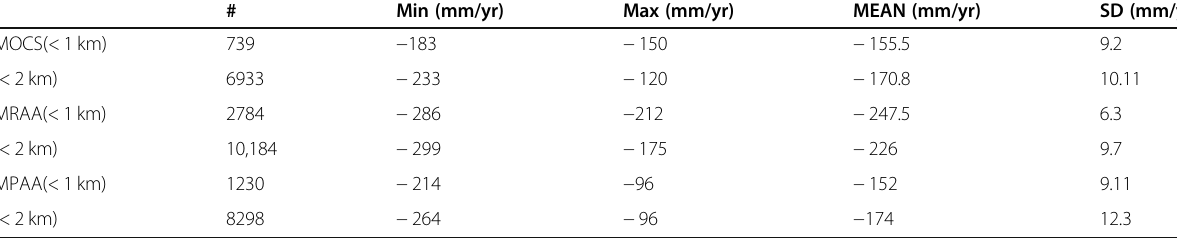
Table 4 Statistics of the selected PSI points around the GPS